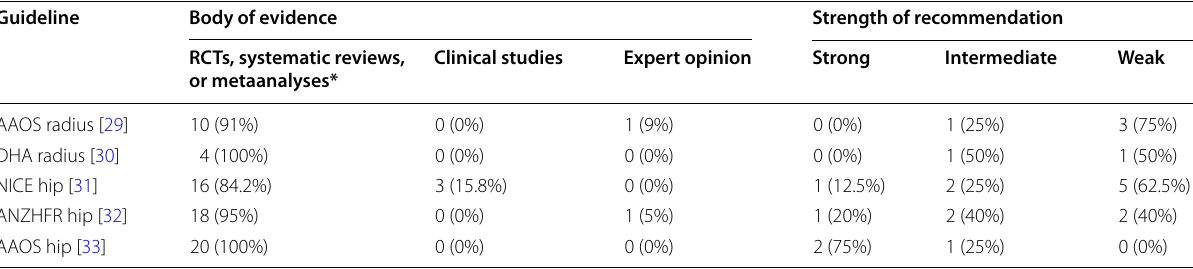
Since the reference scales adopted by each guideline are not directly comparable, we present the recommendations according to two summary three-point Likert scales * At least one RCT or one systematic review are required to classify in this column